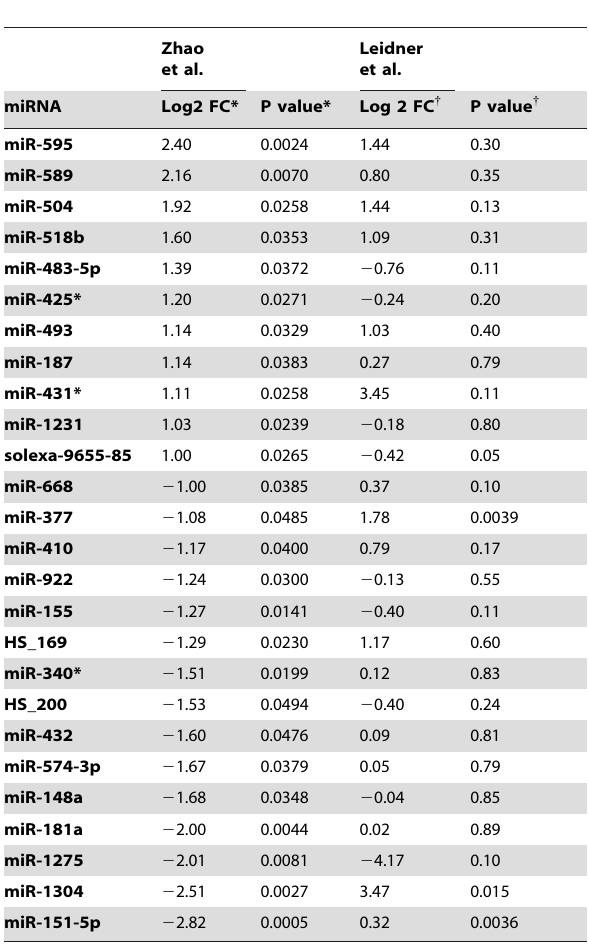
*Modified from Table 1 of Zhao et al.: differentially expressed microRNAs (P , 0.05) with at least two-fold change obtained from case-versus-control comparisons in specimens of all 40 participants. { Fold change and unadjusted p-value from our data, using quantile-normalized background-subtracted data and a t-test to test for significance between the 20 controls and 20 pre-resection breast cancer patients.